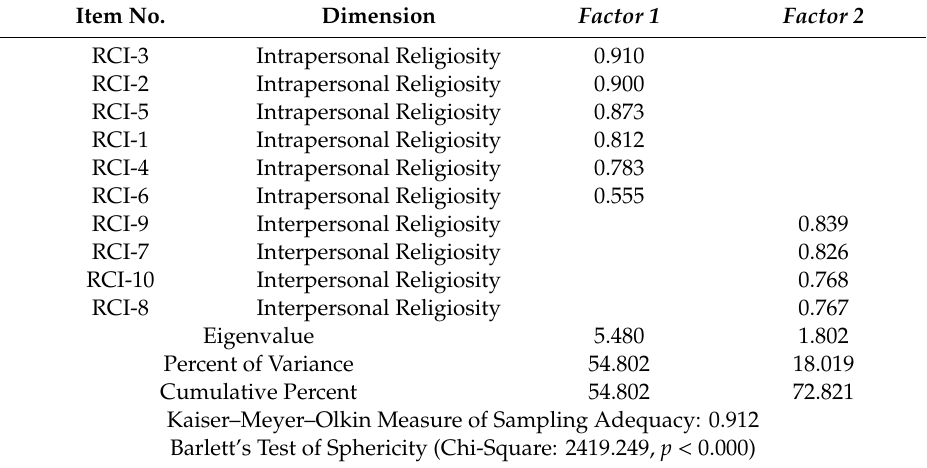
Table 6. Factor Analysis